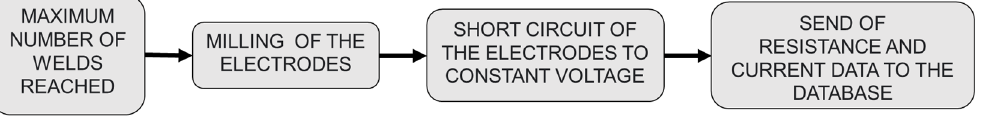
Figure 5. Data acquisition